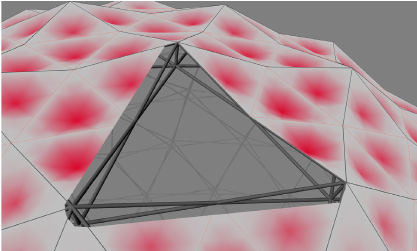
Figure 20: The shape of the membrane under the load